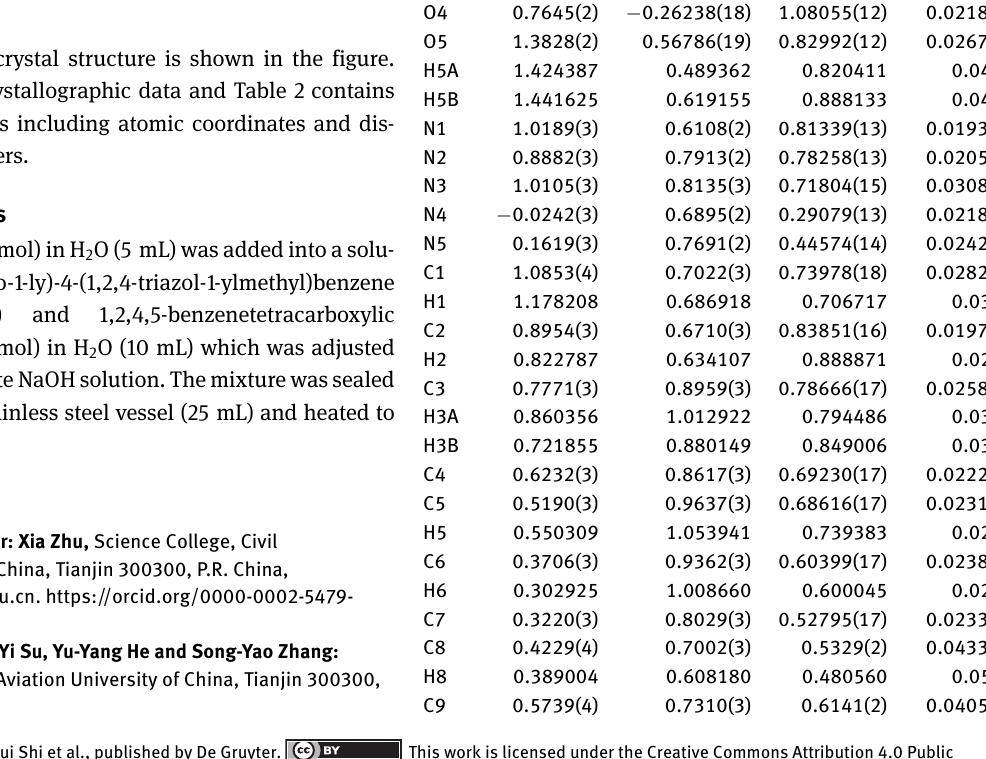
Table 1 contains crystallographic data and Table 2 contains the list of the atoms including atomic coordinates and dis- placement parameters.